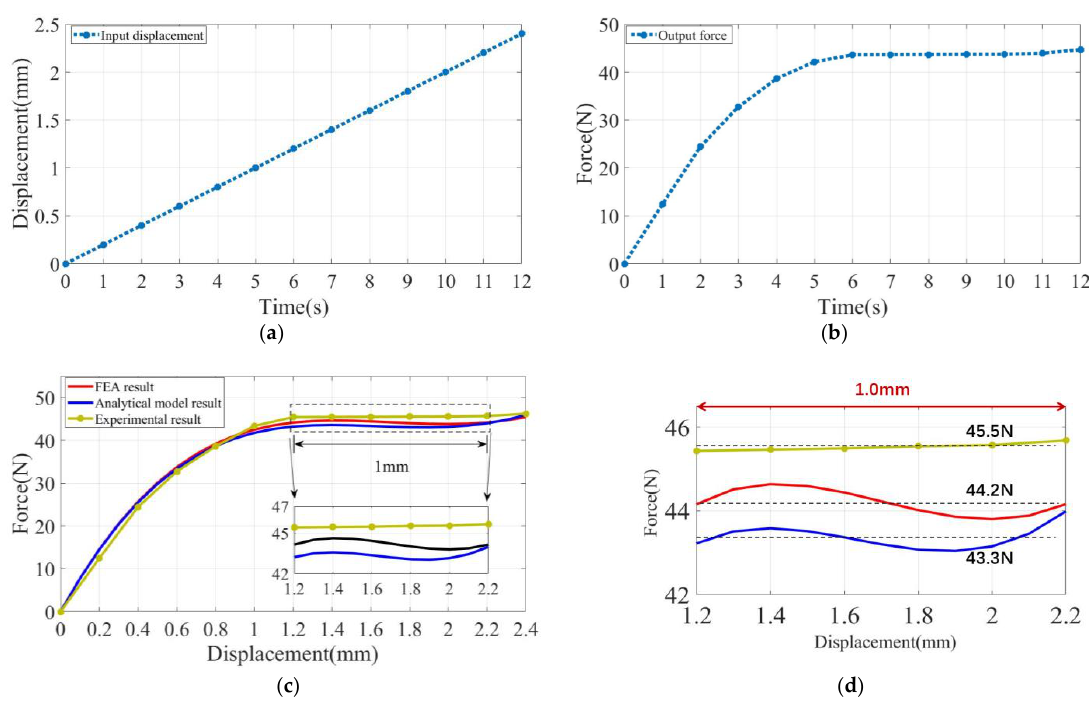
Figure 12. Experimental results: ( a ) displacement output; ( b ) force output; ( c ) constant-force properties of zero-stiffness structures; ( d ) enlarged view of the constant force zone.